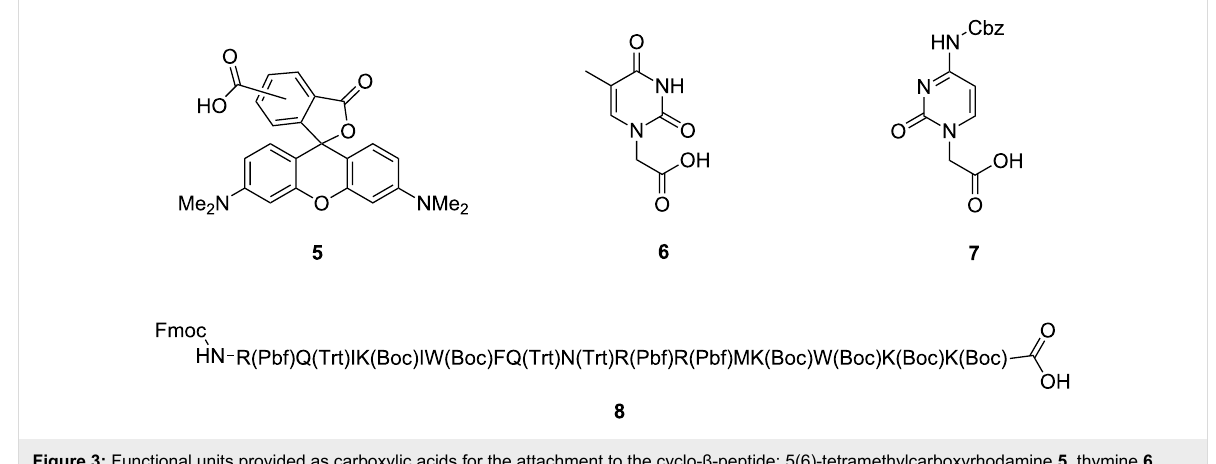
Figure 3: Functional units provided as carboxylic acids for the attachment to the cyclo- β -peptide: 5(6)-tetramethylcarboxyrhodamine 5 , thymine 6 , Cbz protected cytosine with a carboxylic acid linker 7 [25], and fully protected peptide sequence of penetratin 8 [26].